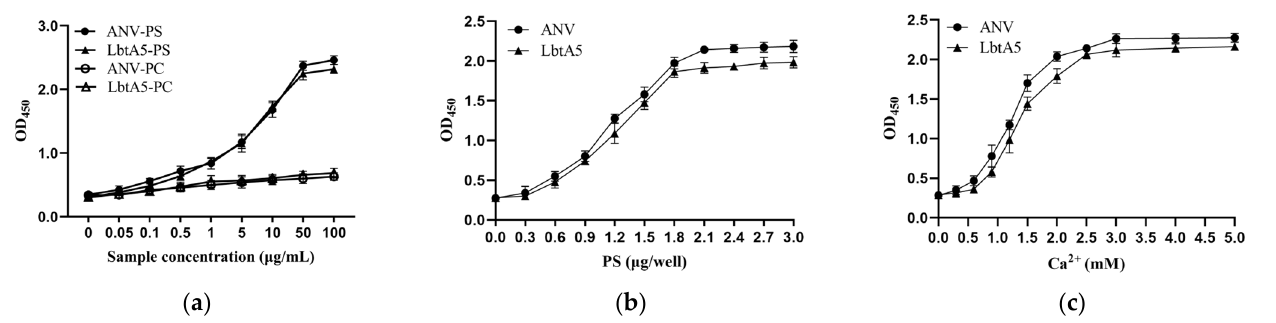
Figure 2. Phospholipid binding analysis of LbtA5 and ANV. ( a ) Binding analysis of ANV and LbtA5 to different cell membrane phospholipids; ( b ) Binding analysis of ANV and LbtA5 to different doses of PS; ( c ) Effect of different Ca 2+ concentrations on the binding of ANV and LbtA5 to phospholipids.